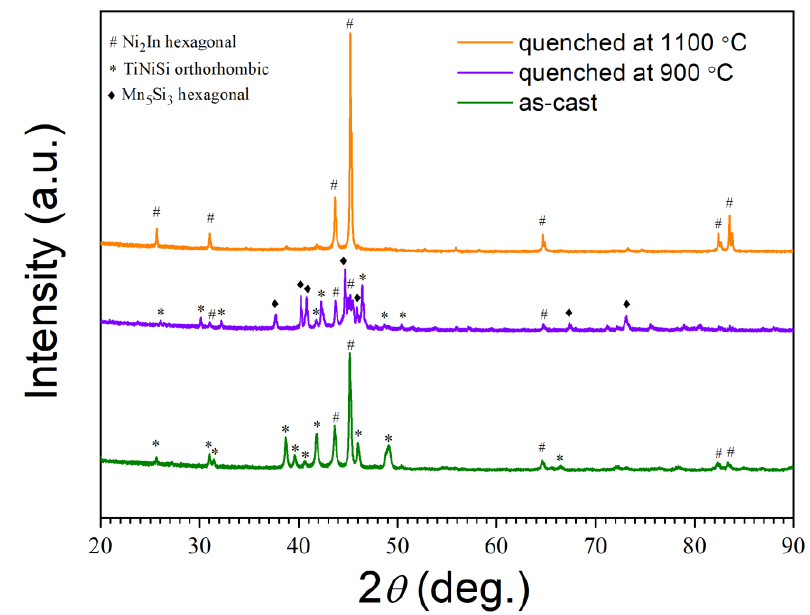
Figure 4. Room-temperature X-ray diffraction patterns of MnFe 0.53 Ni 0.47 Si 0.94 Al 0.06 samples synthe- sized using different conditions.